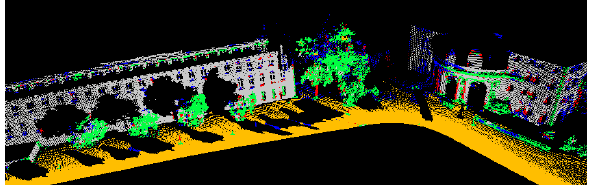
Figure 3: Visual representation of the classification results for the subset consisting of the five best-ranked features (W: blue, P/T: red, F: gray, G: brown, V: